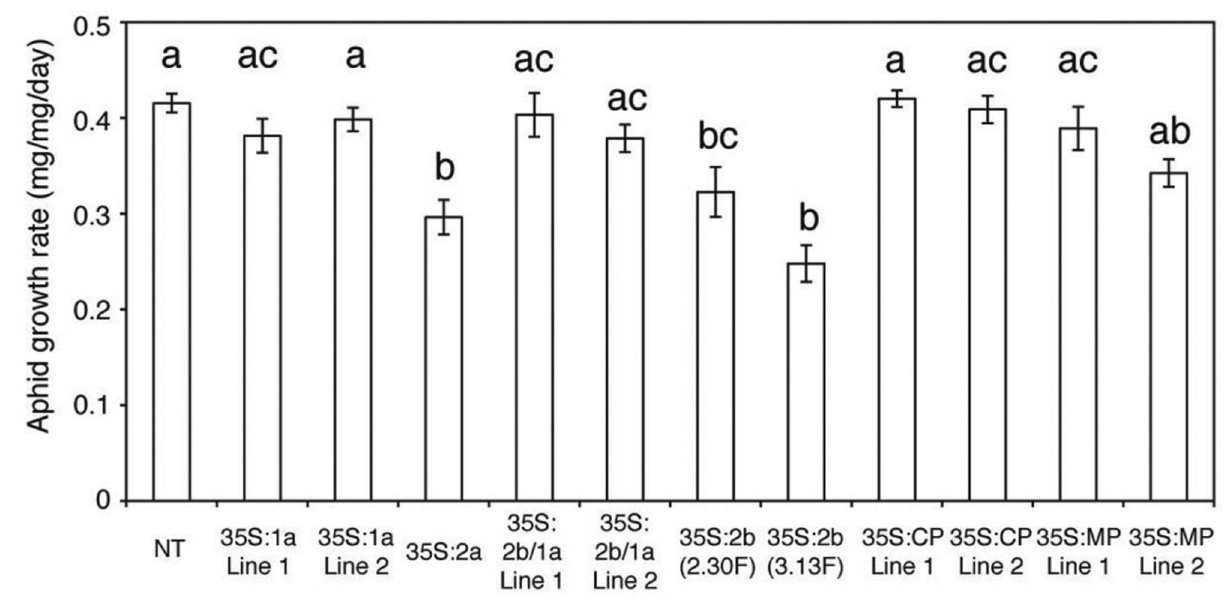
Figure 8. The Fny2a protein induces anti-aphid resistance in transgenic plants. Growth rate of individual aphids feeding on transgenic Arabidopsis plants expressing one or two Fny-CMV proteins and non-transgenic (NT) plants, n≥24. Transgene expression was driven by the constitutive cauliflower mosaic virus 35S promoter. The CMV proteins expressed were the 1a (replicase component), 2a (replicase component), 2b (viral suppressor of RNA silencing), movement protein (MP), and coat protein (CP). Lines indicated by 2b/1a are double transgenic harboring 1a and 2b transgenes. The 2b -transgenic lines 2.30F and 3.13F were constructed by Lewsey et al. [31]. Different letters (a-c) are assigned to statistically different results (ANOVA with post-hoc Tukey’s tests, P <0.05). Error bars represent standard error of the